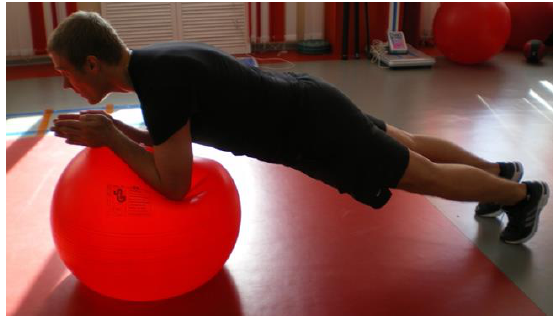
Figure 5. Exercise for coordination on a fitball in a patient after